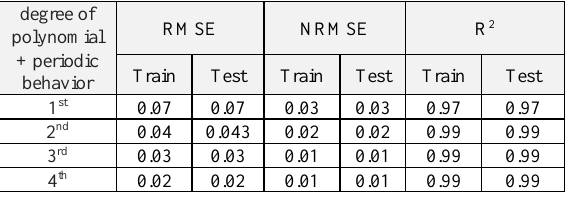
Table 3: Estimate accuracy of Lake water level model by using of time, balance model using time, monthly average of rainfall, evaporation and discharge of lake (polynomial +periodic behavior) degree of polynomial +